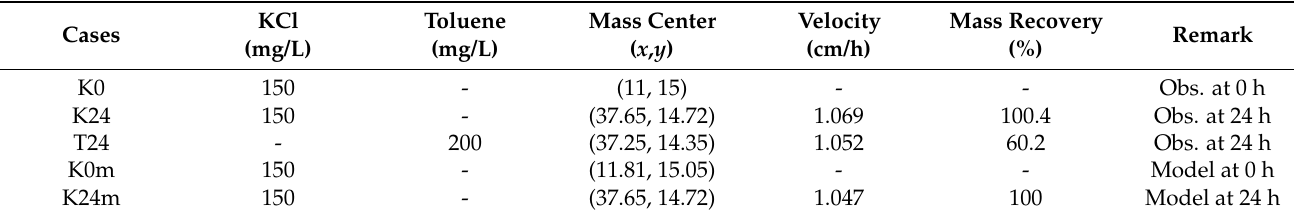
Table 3. Mass center and mass recovery of observed and modeled KCl and toluene plumes obtained through moment analysis.